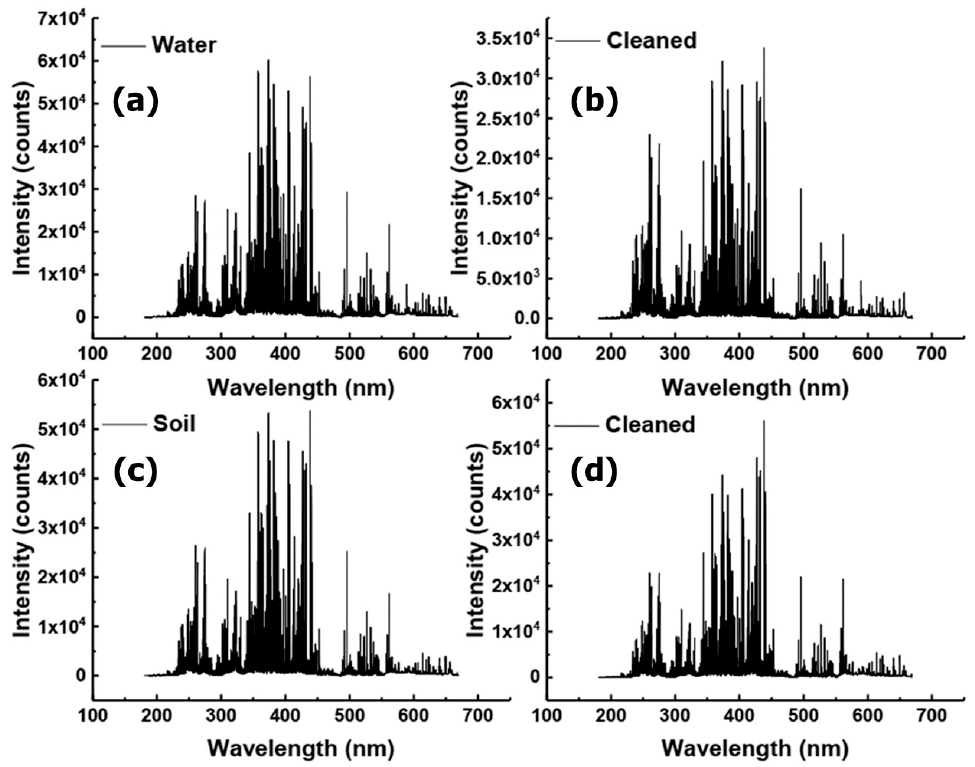
Figure 4. Single element spectral line analysis. ( a ) Contaminated with water, ( b ) laser-cleaned, ( c ) contaminated with soil, and ( d ) laser-cleaned. (Mean values of the 20th to 40th excitation spectra).